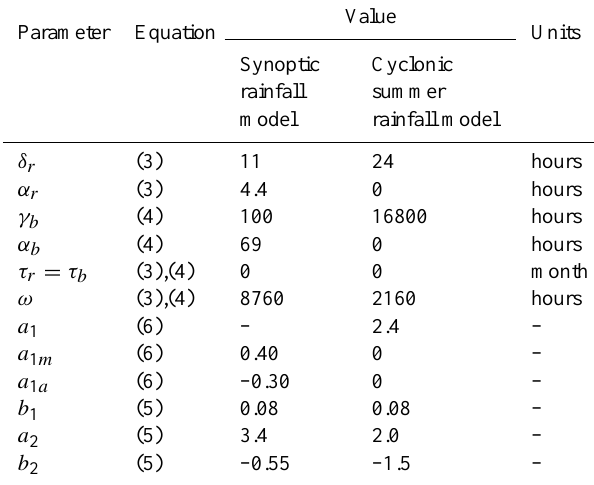
Table 1. Rainfall Model